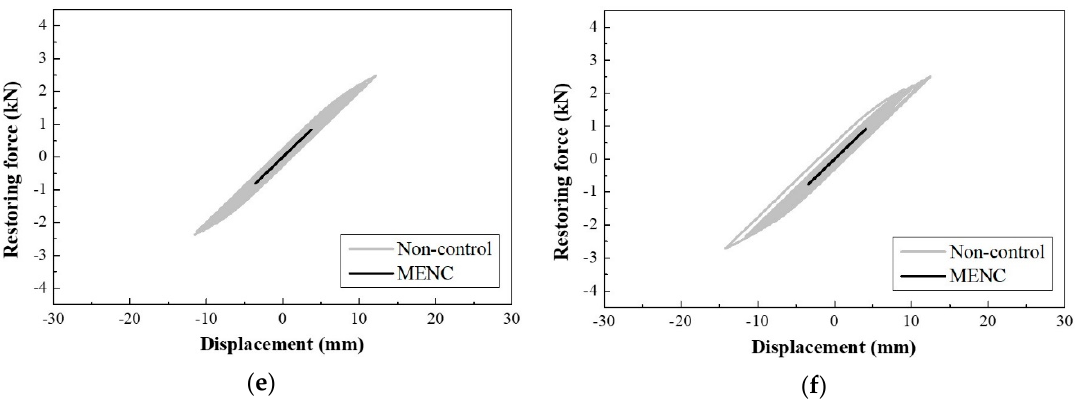
Figure 13. Restoring force vs. displacement on the first floor under the seismic load: ( a ) California earthquake; ( b ) Northridge earthquake; ( c ) Landers earthquake; ( d ) Cape earthquake; ( e ) San Simeon earthquake; ( f ) Loma Prieta earthquake.